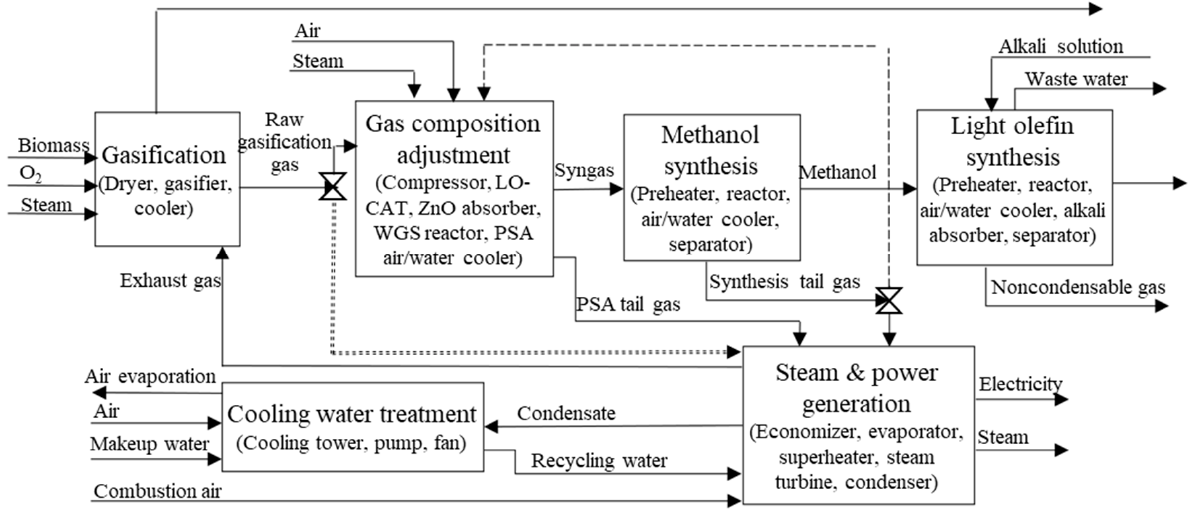
Figure 1. Schematic flow diagram of the proposed biomass-olefin system with a combined-cycle (Base case: solid arrows; Power case: dotted arrows; Fuel case: dashed arrows).